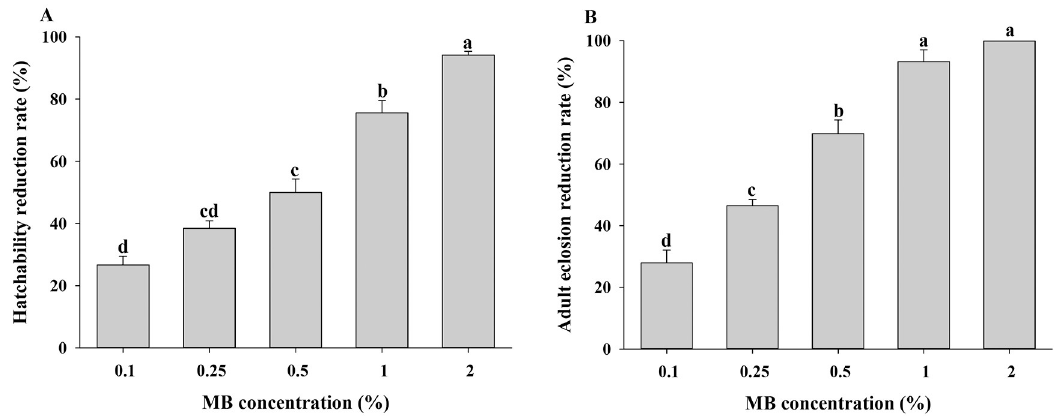
Fig 4. Contact toxicity of methyl benzoate against Bemisia tabaci eggs and fourth-instar nymphs. Tomato leaves infested with 7-d-old eggs (n = 30) or 4-d-old fourth-instar nymphs (n = 15) were dipped into the various concentrations of MB solutions. Egg hatch reduction rates (A) and adult eclosion reduction rates (B) were assessed at 6 d post-treatment. Values are means of three replications. Means denoted by the same letters are not significantly different at α = 0.05 ( N = 3, df = 4, 14; for ovicidal effects, F = 75.82; P < 0.0001; for nymphicidal effects, F = 83.14; P < 0.0001).